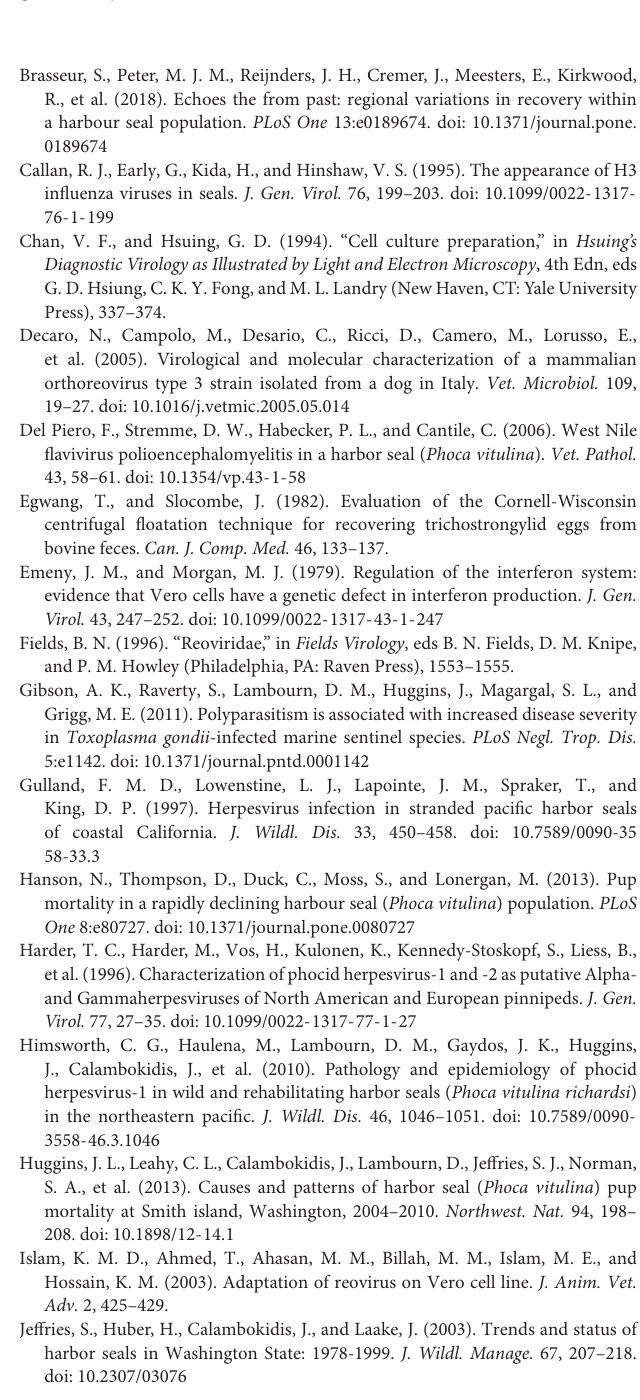
listed, followed by isolate/strain identification when available. Virus abbreviations: MRV1, mammalian orthoreovirus 1; MRV2, mammalian orthoreovirus 2; MRV3, mammalian orthoreovirus 3; MRV4, mammalian orthoreovirus 4. Supplementary Figure 9 | (A) Maximum Likelihood phylogram depicting the relationship of the phocid orthoreovirus 1 to representatives of the Orthoreovirus genus based on the amino acid (aa) sequences of the sigma NS protein (segment S3). Bootstrap values are given at each node and the branch lengths represent the number of inferred substitutions as indicated by the scale. (B) Sequence